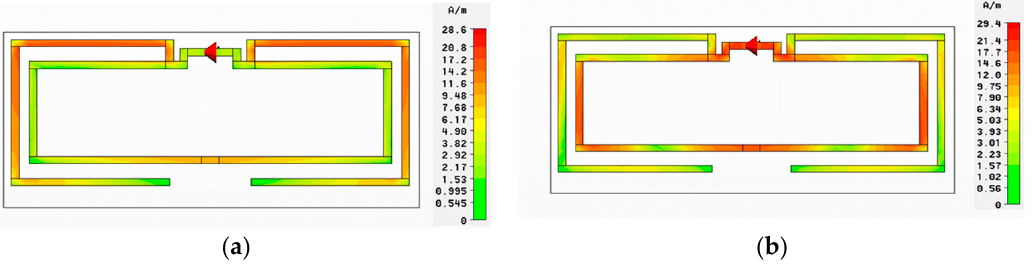
Figure 3. Current distribution in the two loops of the antenna. ( a ) Outer dipole at 2.8 GHz; ( b ) Inner loop at 4.6 GHz. Table 1. Detailed dimensions of proposed antenna.